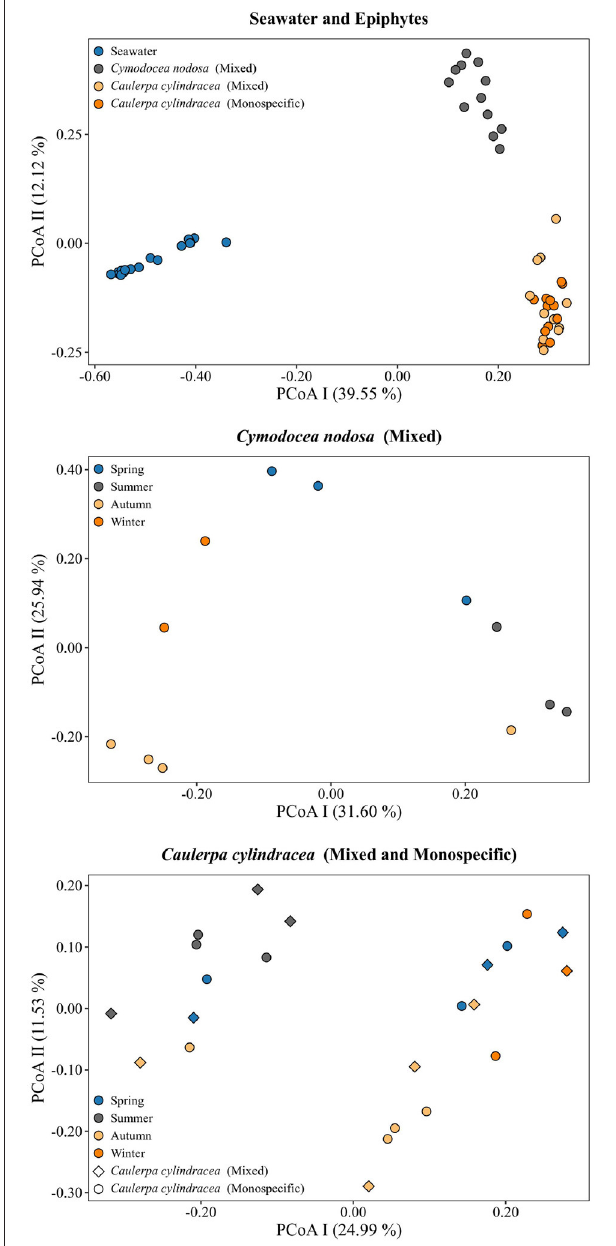
FIGURE 2 | Principal Coordinates Analysis (PCoA) of Bray-Curtis distances based on OTU abundances of bacterial and archeal communities from the surfaces of the macrophytes C. nodosa (mixed settlement) and C. cylindracea (mixed and monospecific settlement) and in the ambient seawater. Samples from different environments or seasons are labeled in different color and shape. The proportion of explained variation by each axis is shown on the corresponding axis in